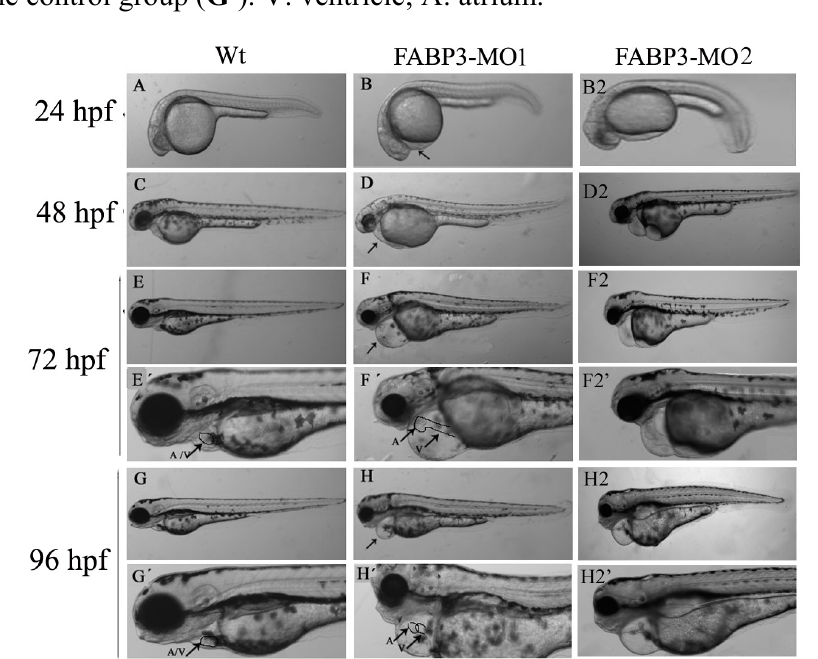
Figure 2. Microinjection of FABP3-MO induced abnormal embryonic development, particularly in the heart. Representative images of zebrafish embryos are shown. Compared to the Wt-MO group ( A ), embryos injected with FABP3-MO at 24 hpf ( B , B2 ) displayed slightly pericardial edema (black arrows and developmental delay). At 48 hpf, FABP3-MO1 and FABP3-MO2 injected zebrafish embryos ( D and D2 ) displayed phenotypes similar to the embryos treated at 24 hpf, except with abnormal somites and head malformations which were not seen in age-matched control embryos ( C ). These defects appeared more severe at 72 hpf in the FABP3-MO1 and FABP3-MO2 group ( F , F2 ) compared to the control group ( E ). Similarly, severe abnormalities were observed in FABP3-MO1 and FABP3-MO2 injected embryos at 96 hpf ( H , H2 ), but not control embryos ( G ). Higher magnification (630 multiple) images of embryos are shown in part 2 at 72 and 96 hpf. FABP3-MO injected embryos show overlapping of the ventricle and atrium, and a linear heart tube at 72 hpf ( F ′ , F2 ′ ), which was not evident in control embryos ( E ′ ). Similarly, the ventricle and atrium could be viewed at the same position at 96 hpf embryos in the FABP3-MO group ( H ′ , H2 ′ ), but not in the control group ( G ′ ). V: ventricle; A: